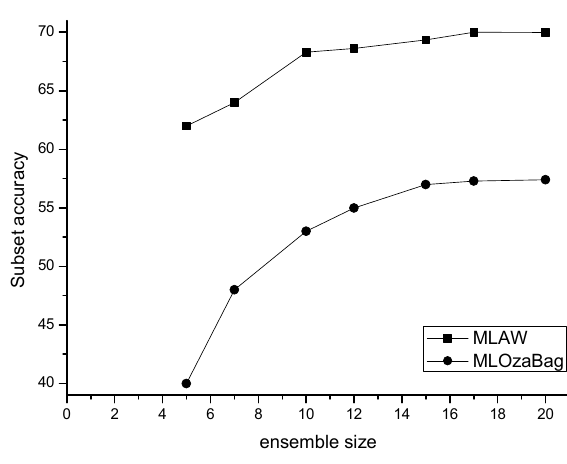
Figure 4. Varying the size of ensemble.